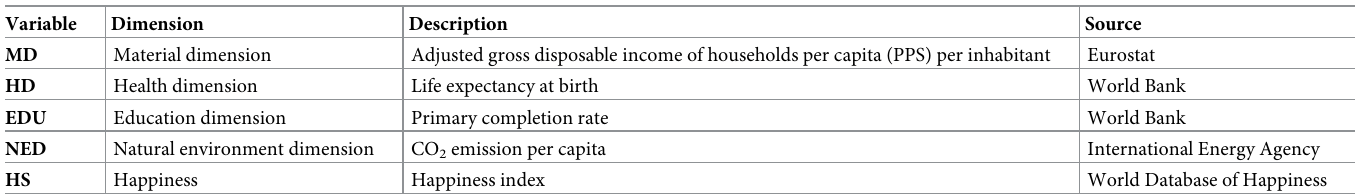
Table 1. The description and sources of data concerning dimensions of